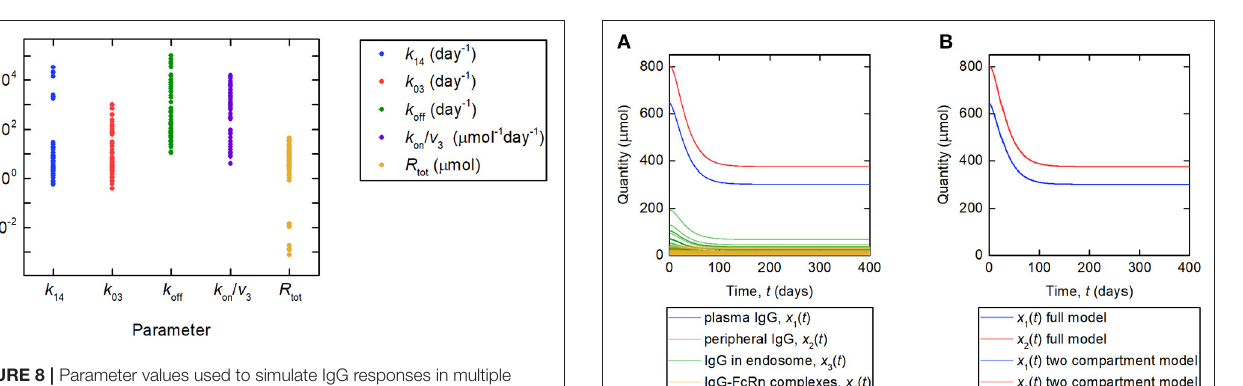
FIGURE 8 | Parameter values used to simulate IgG responses in multiple myeloma, plotted on a logarithmic scale. The method used to generate the parameter values is described in section 3.3. The model predictions generated using these parameter values are shown in Figure 9A . Despite the large amount of variation in the parameter values, the model predictions for plasma IgG are extremely similar.